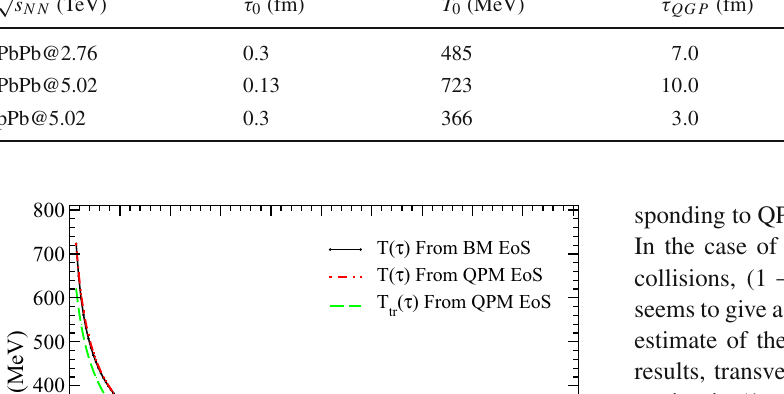
√ s NN at most central collisions, i.e. N part